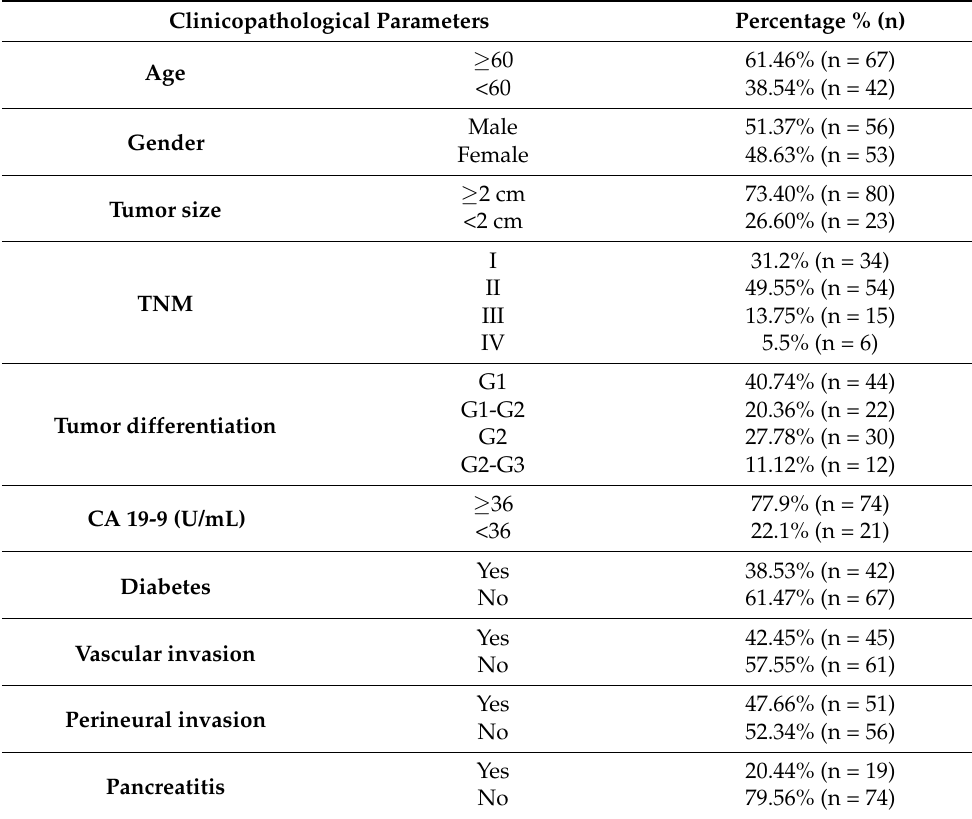
Table 1. Clinicopathological characteristics of Fundeni Clinical Institute patients used for validation of the selected TRP genes by qRT-PCR and